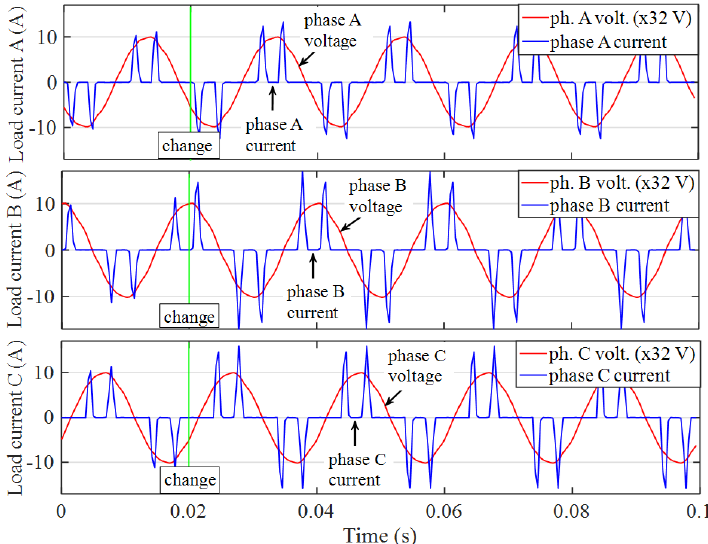
Figure 16. Experimental dynamic performance including load unbalance. At time labeled as t = 0.02 s, a change occurs from balanced to unbalanced load. Each graph shows one of the phases together with its respective source voltage.